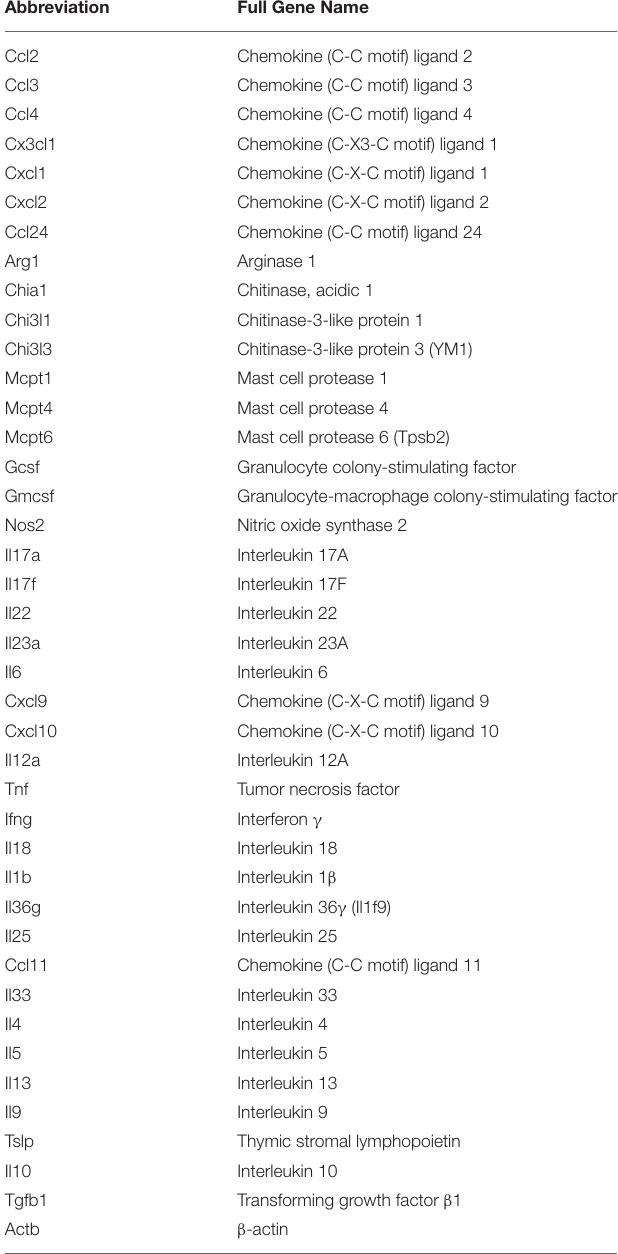
TABLE 1 | Gene abbreviations for the qPCR assays in this